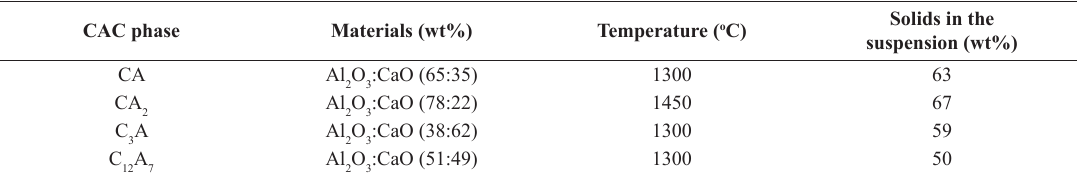
O -CaO mixture and the respective 2 3